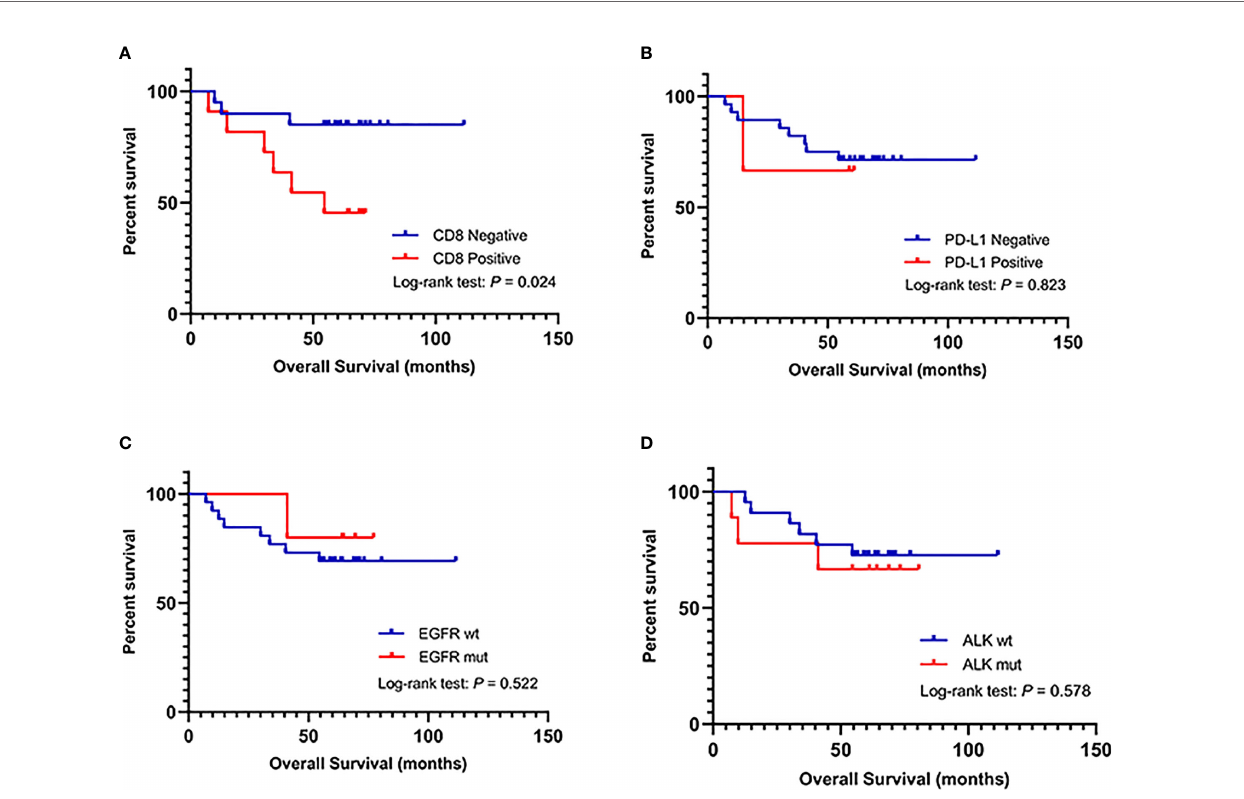
FIGURE 3 | (A) Kaplan – Meier analysis of overall survival (OS) in IMA patients based on CD8+ TIL in fi ltration. (B) Kaplan – Meier analysis of OS in IMA patients based on PD-L1 expression. (C) Kaplan – Meier analysis of OS in IMA patients based on EGFR mutations. (D) Kaplan – Meier analysis of OS in IMA patients based on ALK mutations.